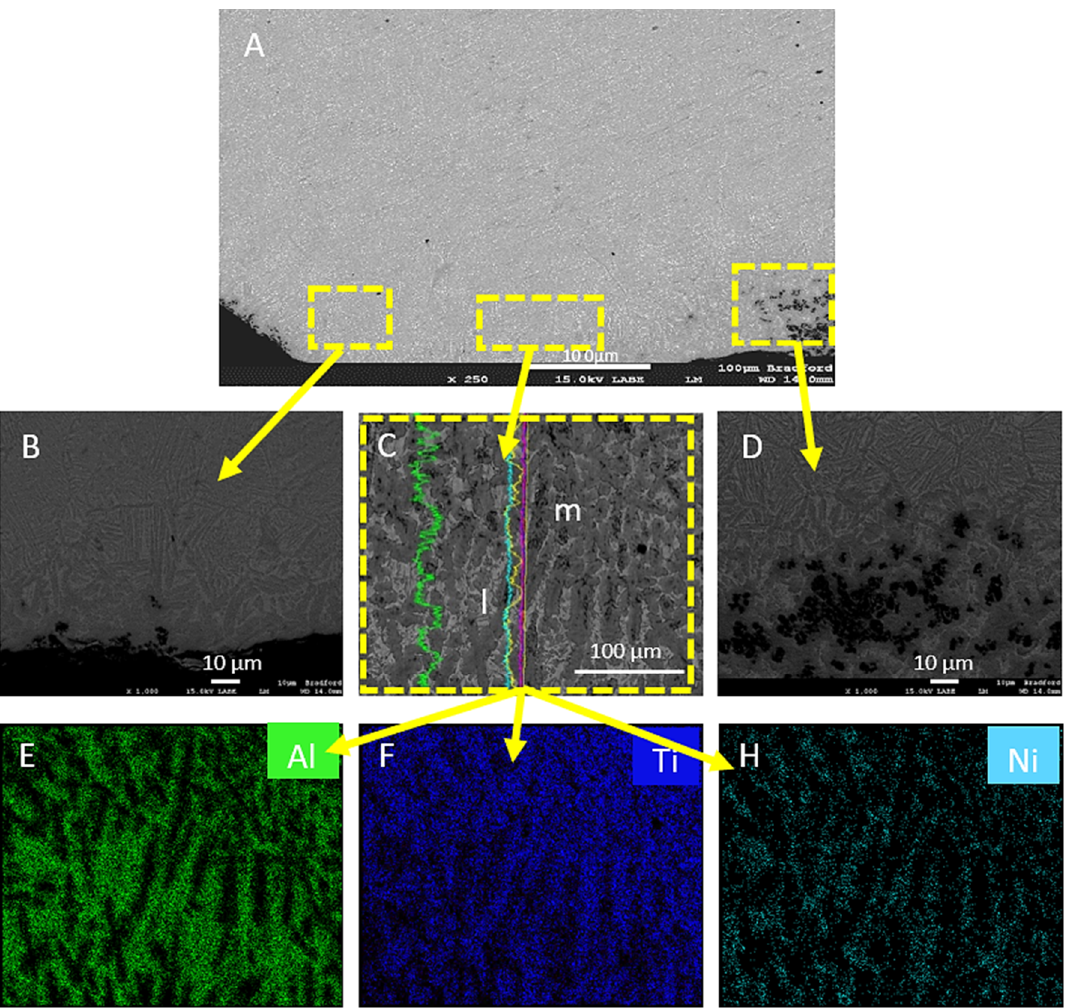
Figure 7. ( A ) Ti-6Al-4V sample electrodeposited with Ni / Al 2 O 3 + 250 nm diameter TiO 2 particles and surface melted with a welding current of 100 A. ( B ) Low-resolution image of the treated layer. ( C ) Detailed view of the microstructure along the surface. ( D ) Micrograph showing particle segregation. EDS maps of ( E ) Nickel, ( F ) Titanium, ( G ) Aluminium.